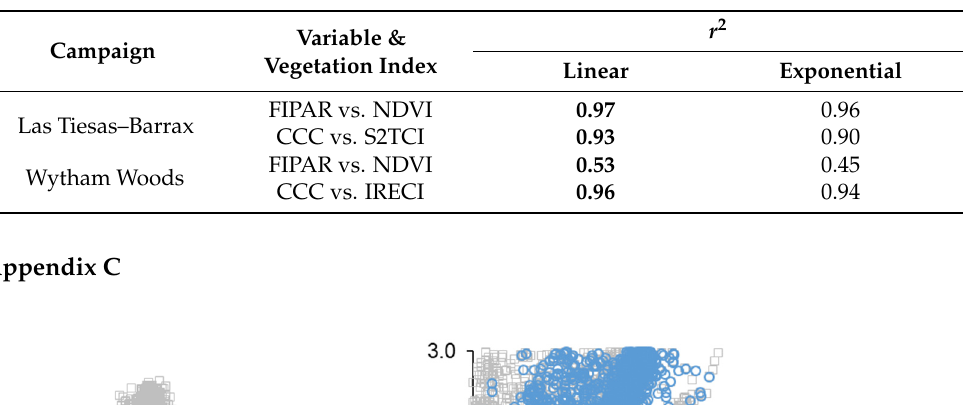
Table A2. Coefficient of determination ( r 2 ) associated with linear and exponential fits between in situ measurements and vegetation indices. The best performing fit is shown in bold.